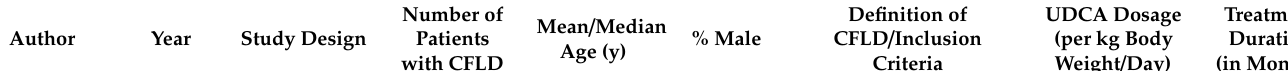
Table 1. Ursodeoxycholic Acid as Treatment for Cystic Fibrosis-Related Liver